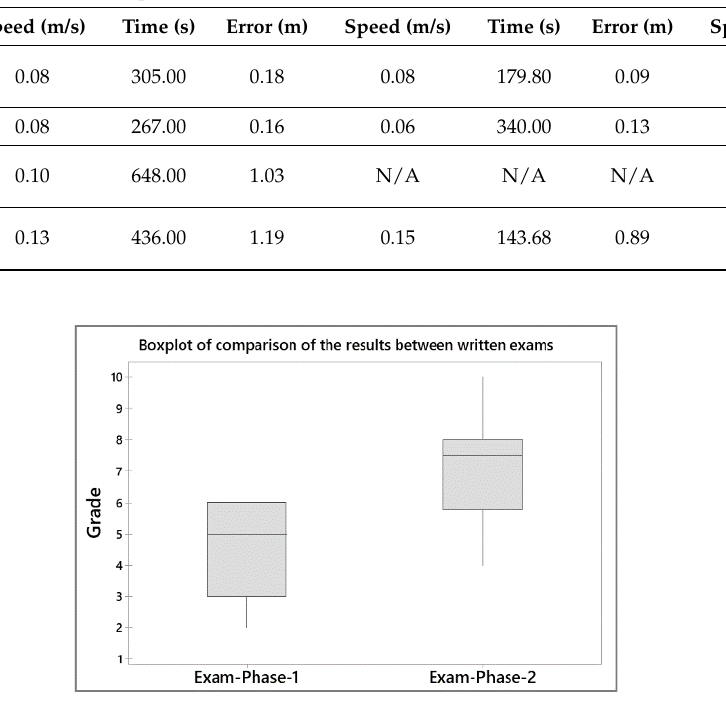
Figure 14. Comparison between the results of the written exams of phase 1 and 2.